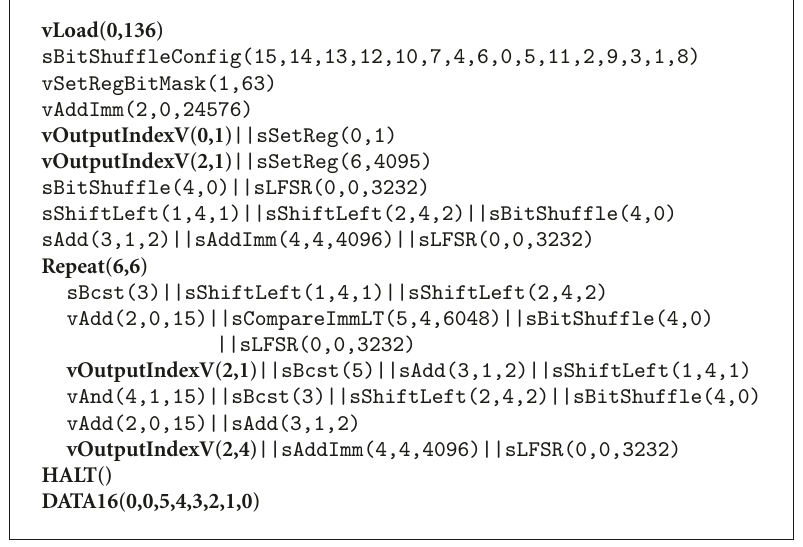
Algorithm 3: iVAG assembly code for DVB-T 8K 64QAM symbol